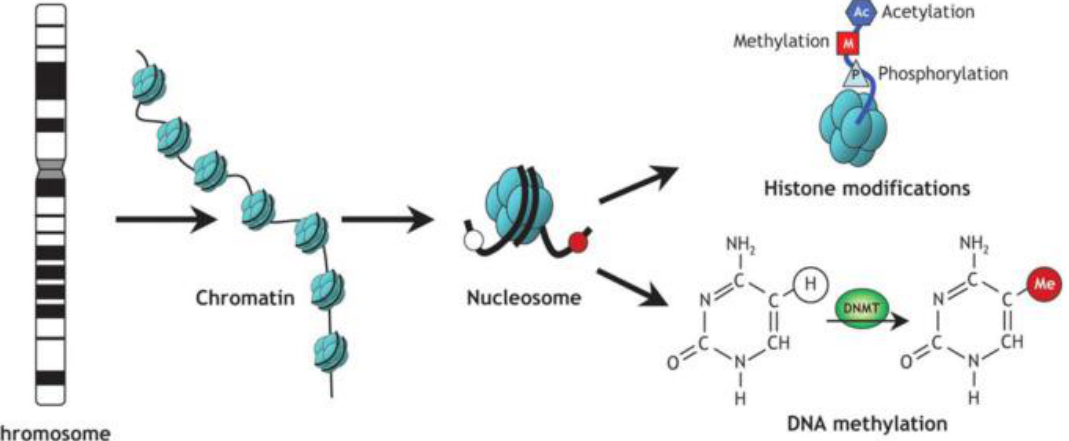
Figure 1. Schematic of epigenetic modifications. Strands of DNA are wrapped around histone octamers, forming nucleosomes, which organize the chromatin. Reversible and site-specific histone modifications occur at multiple sites through acetylation, methylation and phosphorylation. DNA methylation occurs at the 5-position of cytosine residues in a reaction catalyzed by DNA methyltransferases (DNMTs). Together, these modifications provide a unique epigenetic signature that regulates chromatin organization and gene expression [6].